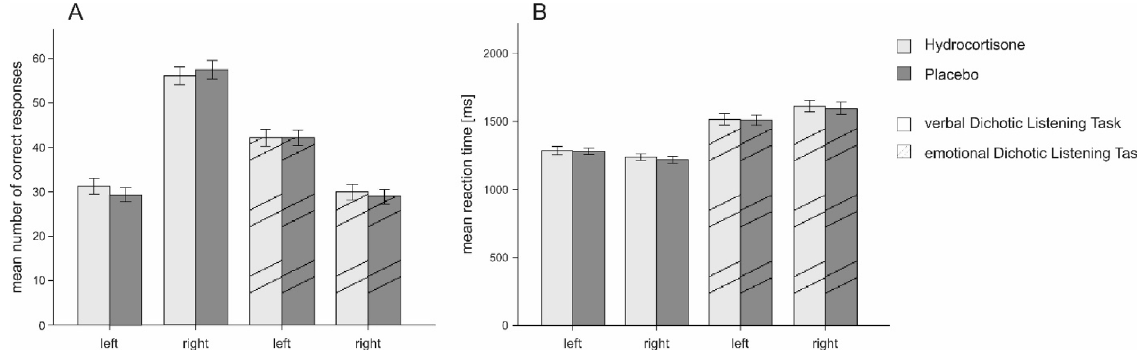
Figure 4. Mean number of correct responses per ear ( A ) and mean reaction times in ms ( B ). Solid bars indicate the verbal dichotic listening task; striped bars indicate the emotional dichotic listening task. Participants reported more stimuli presented and were faster in responding to stimuli on the right than on the left side indicating a left hemispheric lateralization for language for the verbal dichotic listening task. Participants reported more stimuli presented and were faster in responding to stimuli on the left than on the right side indicating a right hemispheric lateralization for emotion processing for the emotional dichotic listening task. Error bars represent ± 1